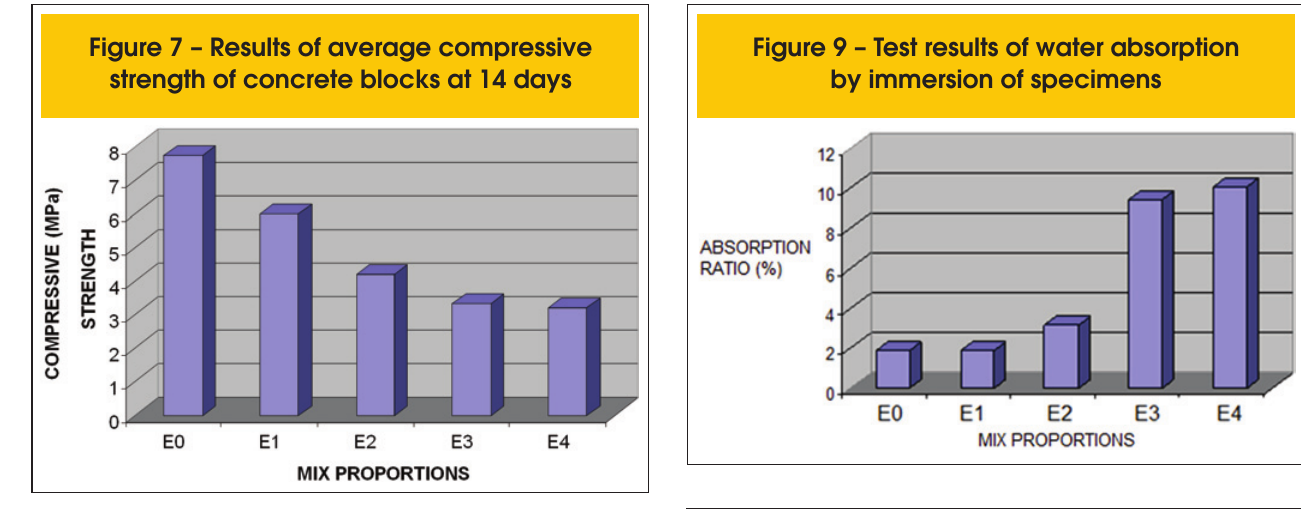
Figure 7 – Results of average compressive strength of concrete blocks at 14 days